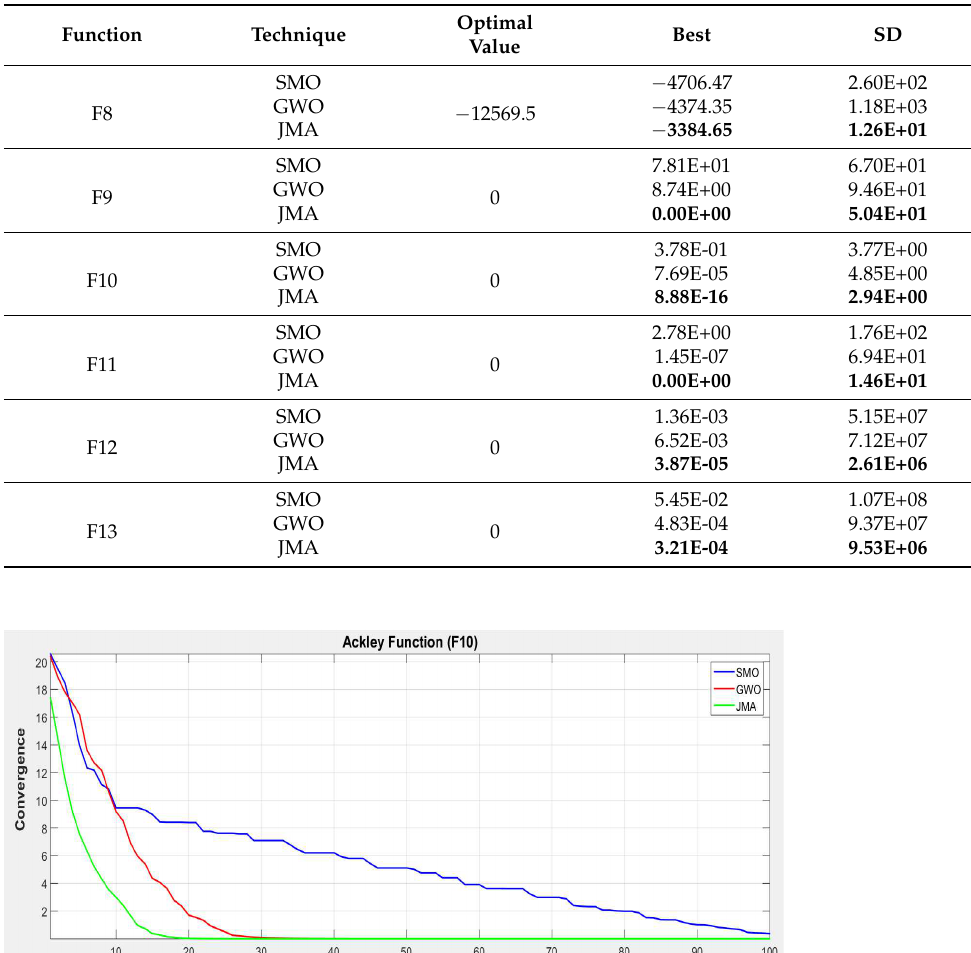
Table 5. Experimental results of the multimodal benchmark function.